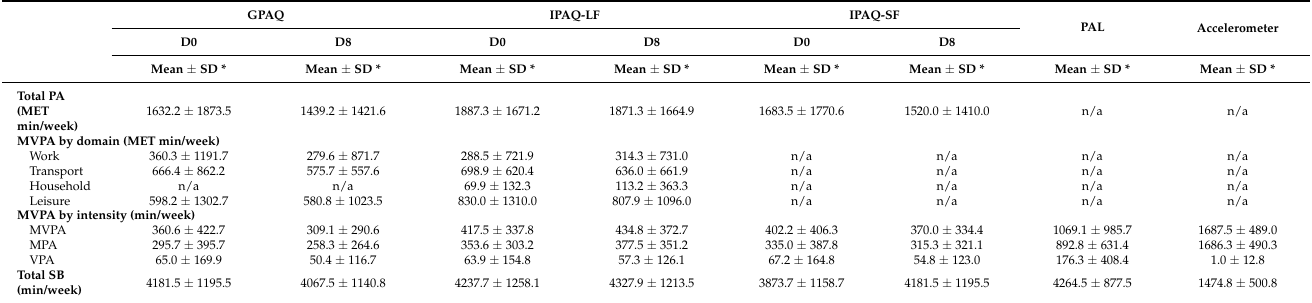
Table 2. Data for physical activity and sedentary behaviour measured by GPAQ, IPAQ-LF, IPAQ-SF, PAL and accelerometer.